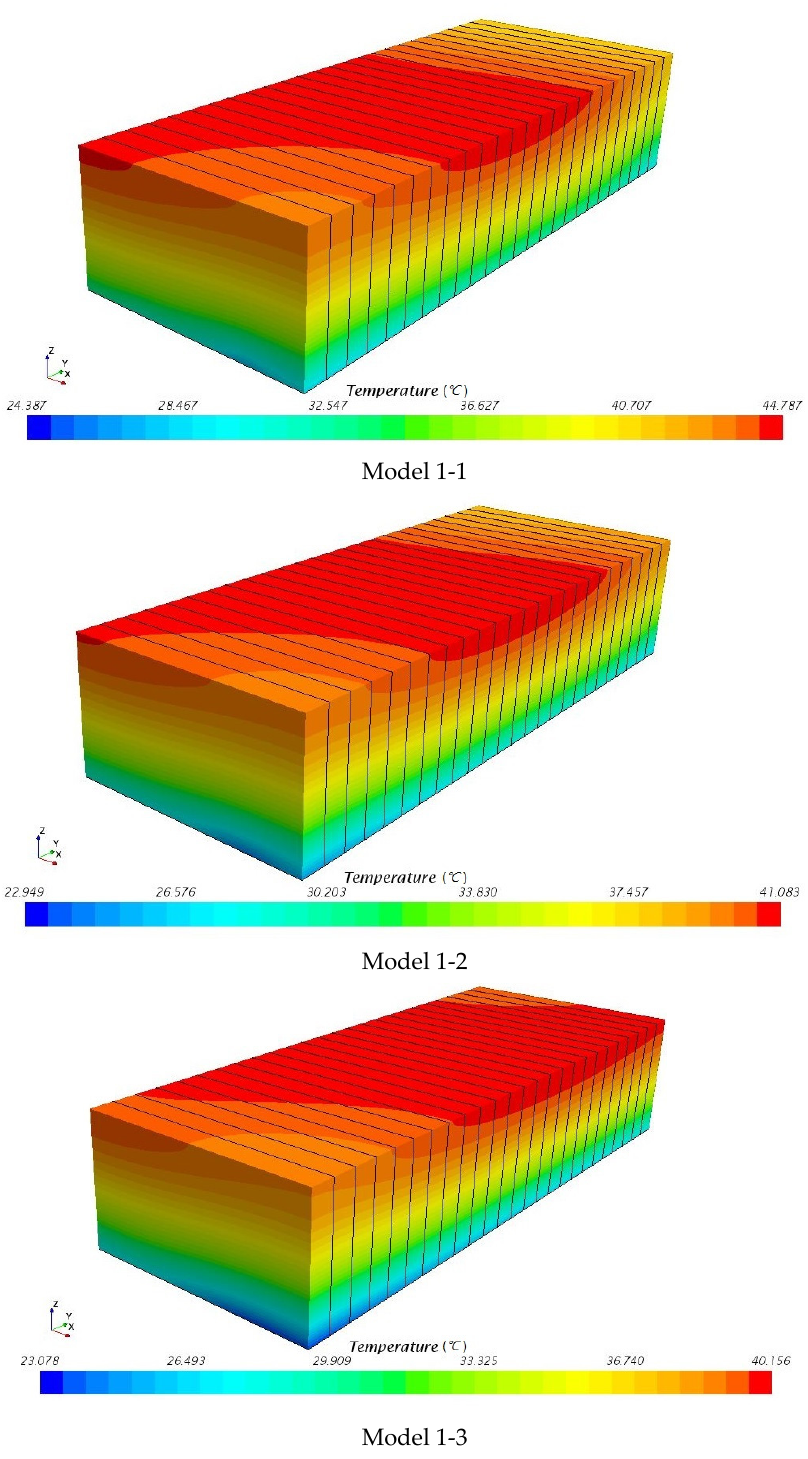
Figure 8. Temperature distributions of the three models with the bottom cooling system.